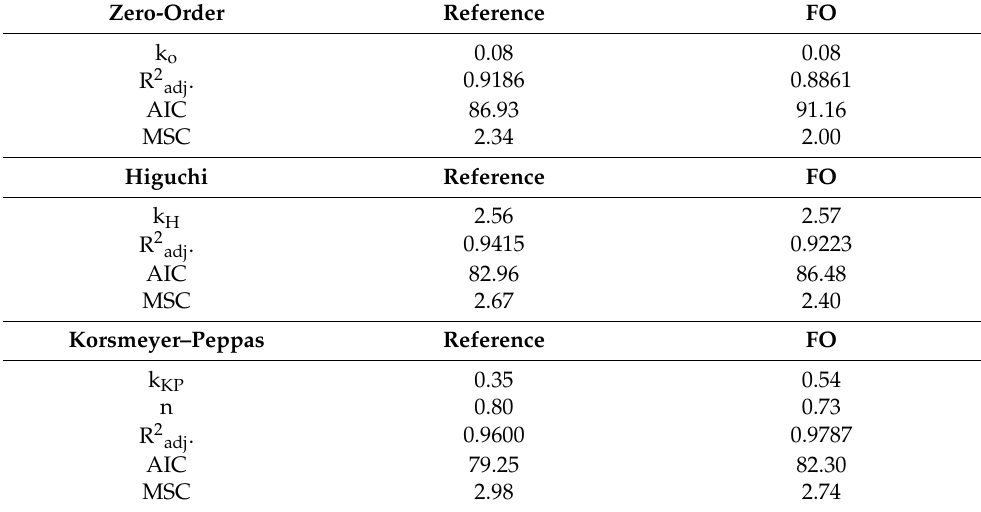
and model selection criteria (MSC) were obtained for each